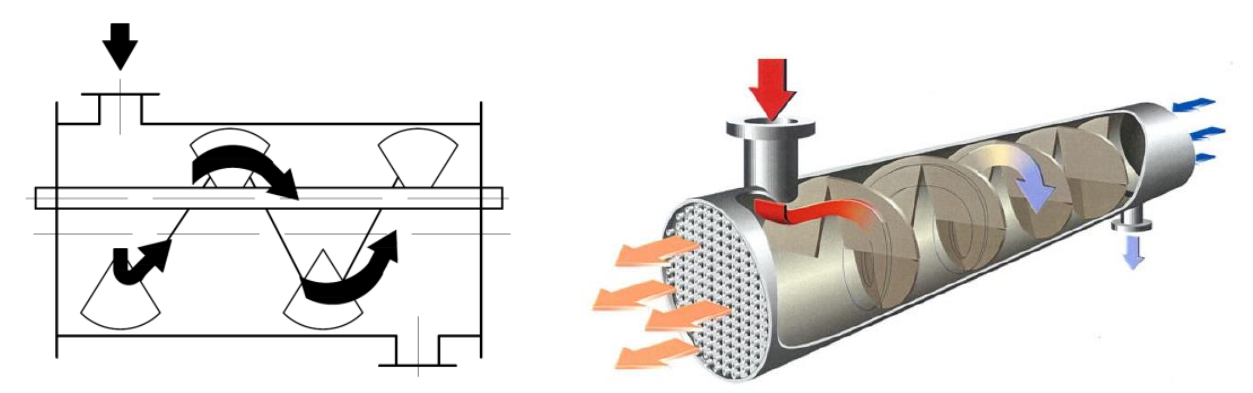
Figure 2. Shell and tube heat exchanger with a helicoidal baffle [29,30].